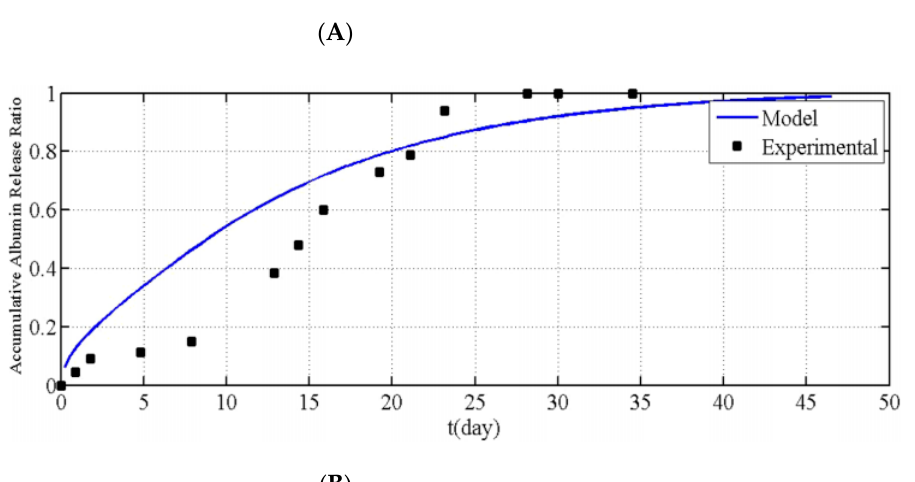
Figure 6. Relationship between the accumulative ( A ) aspirin and ( B ) albumin release ratio vs. time for modelling results and experiments, as reported by Chavoshi et al., reproduced with permission from [21], Springer Nature, 2019.